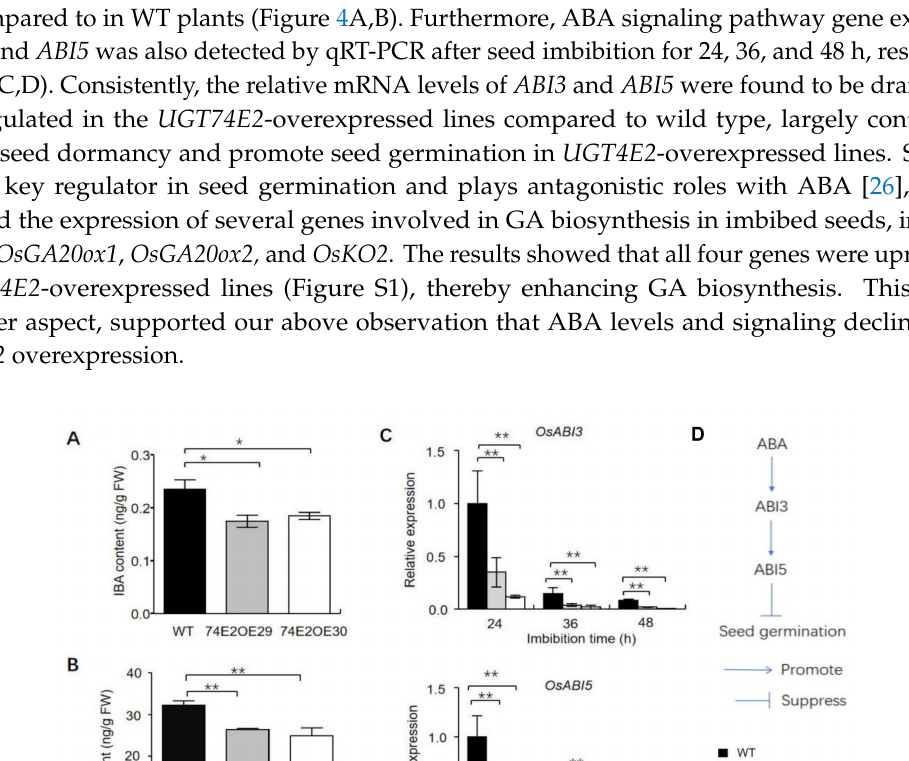
Here, at least 30 seeds were observed for each line (bars = 3 cm). ( B ) Time to 50% germination and four-day germination rates were calculated in the presence of IBA and ABA. ( C ) Shoot and root lengths of UGT74E2- overexpressed lines in the presence of IBA and ABA (scale bars = 3 cm). Experiments were conducted for three biological replicates. Bars represent standard deviation of at least 10 seedlings.